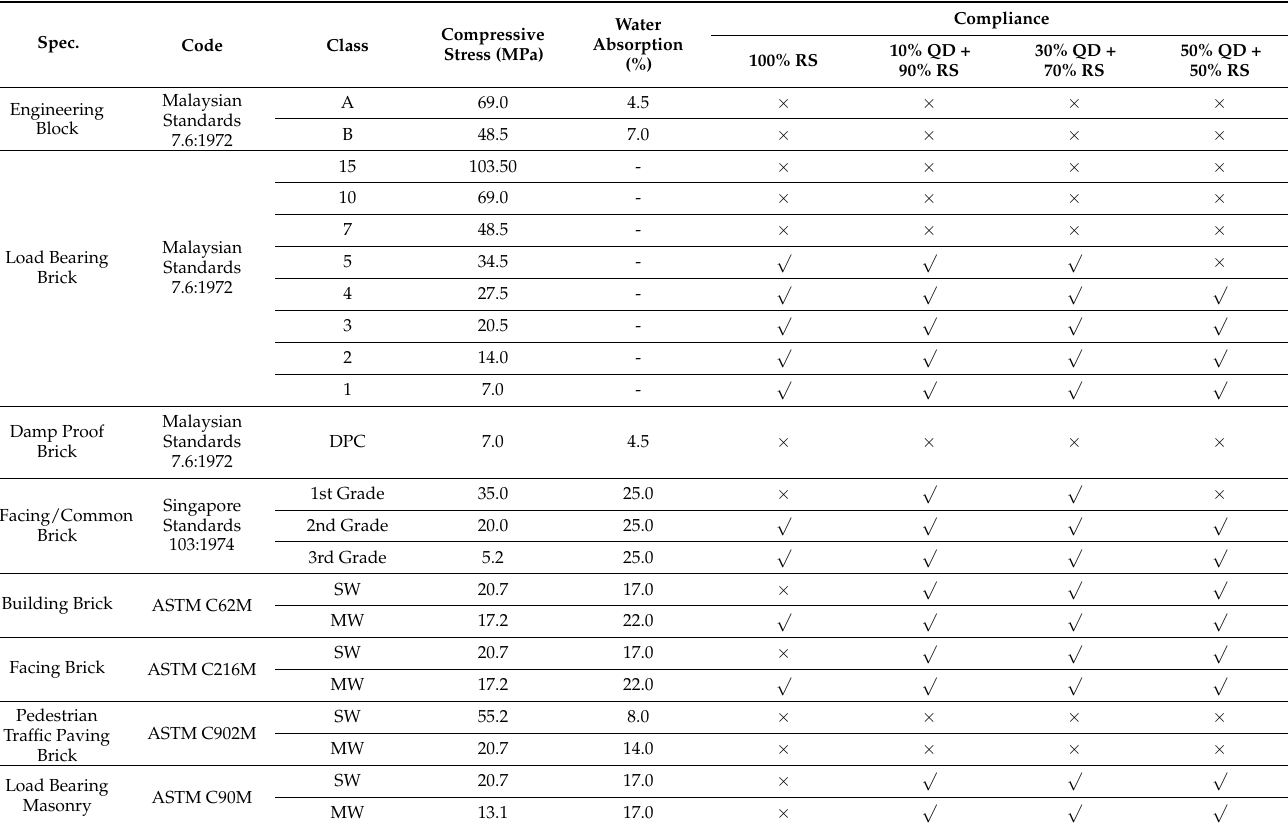
Table 8. Code compliance for the design